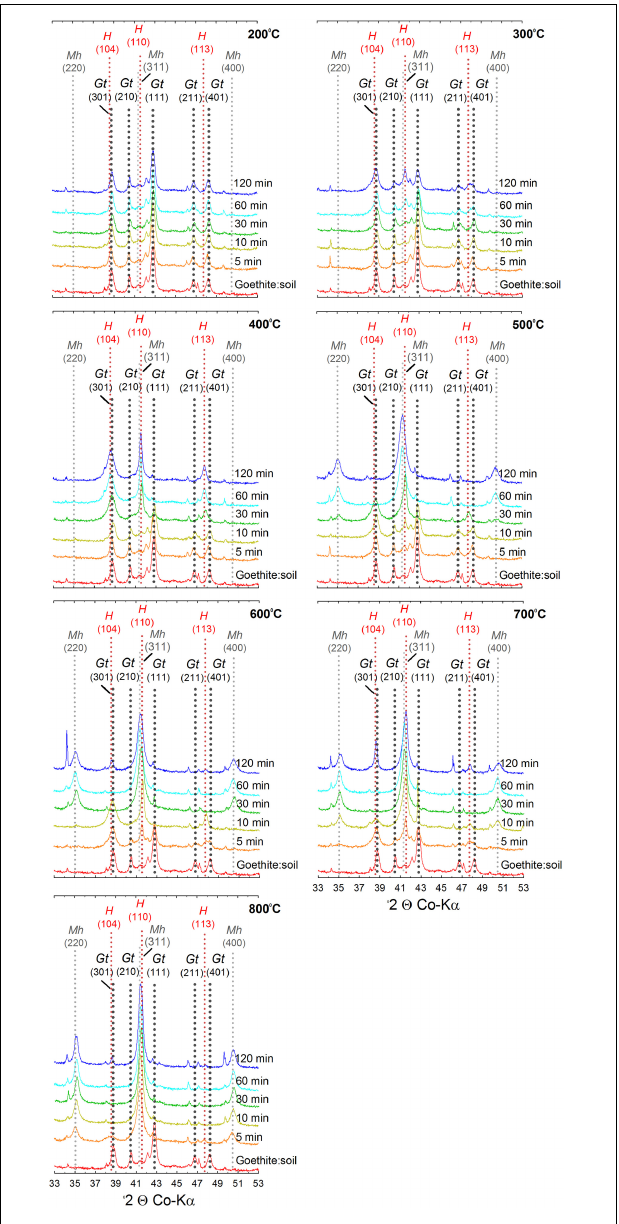
FIGURE 4 | X-ray diffractograms of goethite:soil mixtures after heating at 200, 300, 400, 500, 600, 700, and 800 ◦ C for 5, 10, 30, 60, and 120 min. Gt, goethite; Mh, maghemite; H, hematite; Q,